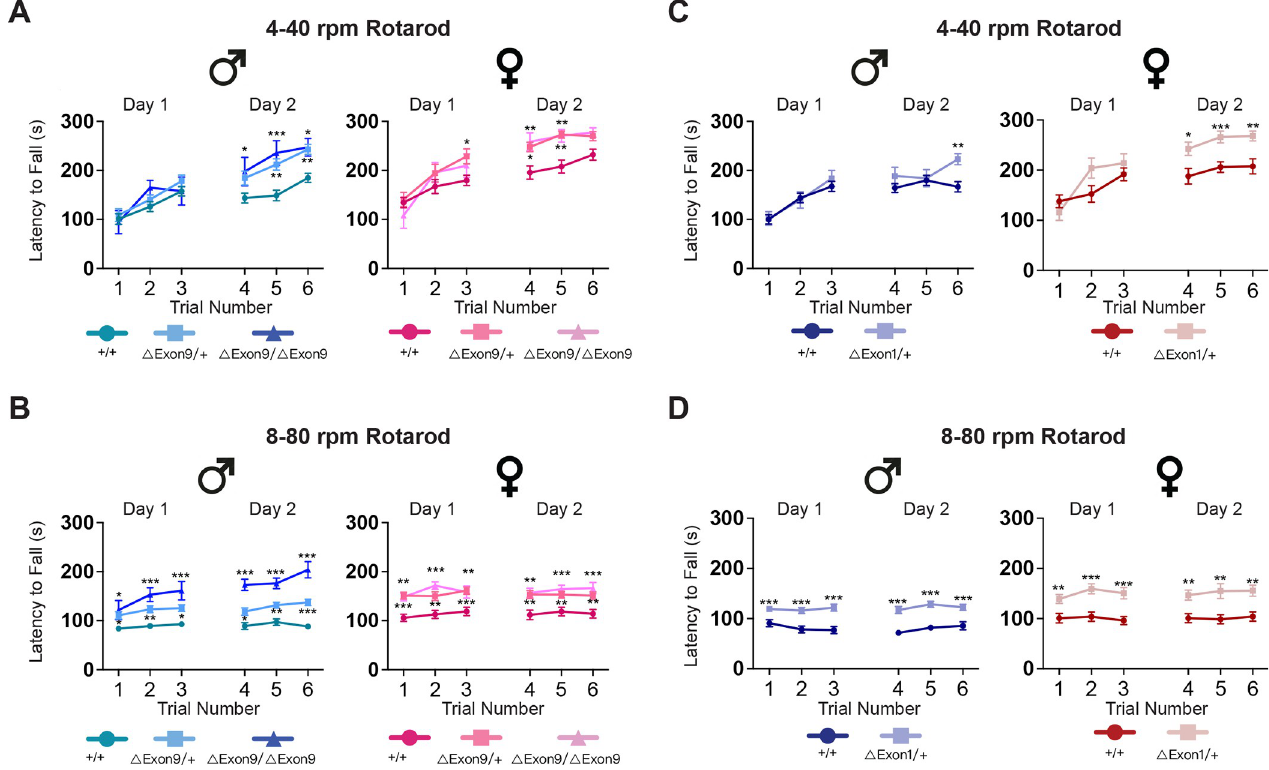
Fig 6. A reduction in Nrxn1 α expression enhances the motor skill learning and motor coordination. A-B . (A) Latency to fall (in seconds) for +/+, Δ Exon9/ +, and Δ Exon9/ Δ Exon9 male (left) and female (right) mice on the standard accelerating rotarod (4–40 rpm in 5 min). Mice were tested over 3 trials per day for 2 consecutive days. (B) Latency to fall of the same male (left) and female (right) mice from (A) on a higher accelerating rotarod (8–80 rpm in 5 min). Mice were tested over 3 trials per day for the next 2 consecutive days. Two-way repeat measure ANOVA test with Dunnett’s multiple comparison test, � p < 0.05; �� p < 0.01; ��� p < 0.001. C-D. (C) Latency to fall (in seconds) for +/+ and Δ Exon1/+ male (left) and female (right) mice on the standard accelerating rotarod (4–40 rpm in 5 min). Mice were tested over 3 trials per day for 2 consecutive days. (D) Latency to fall of the same +/+ and Δ Exon1/+ male (left) and female (right) mice from (C) on a higher accelerating rotarod (8–80 rpm in 5 min). Two-way repeat measure ANOVA test with Sidak’s multiple-comparison test, � p < 0.05; �� p < 0.01; ��� p < 0.001. The number of animals used in each group in the high speed rotarod is the same as those in Fig 2. Data are represented as mean ± SEM in all